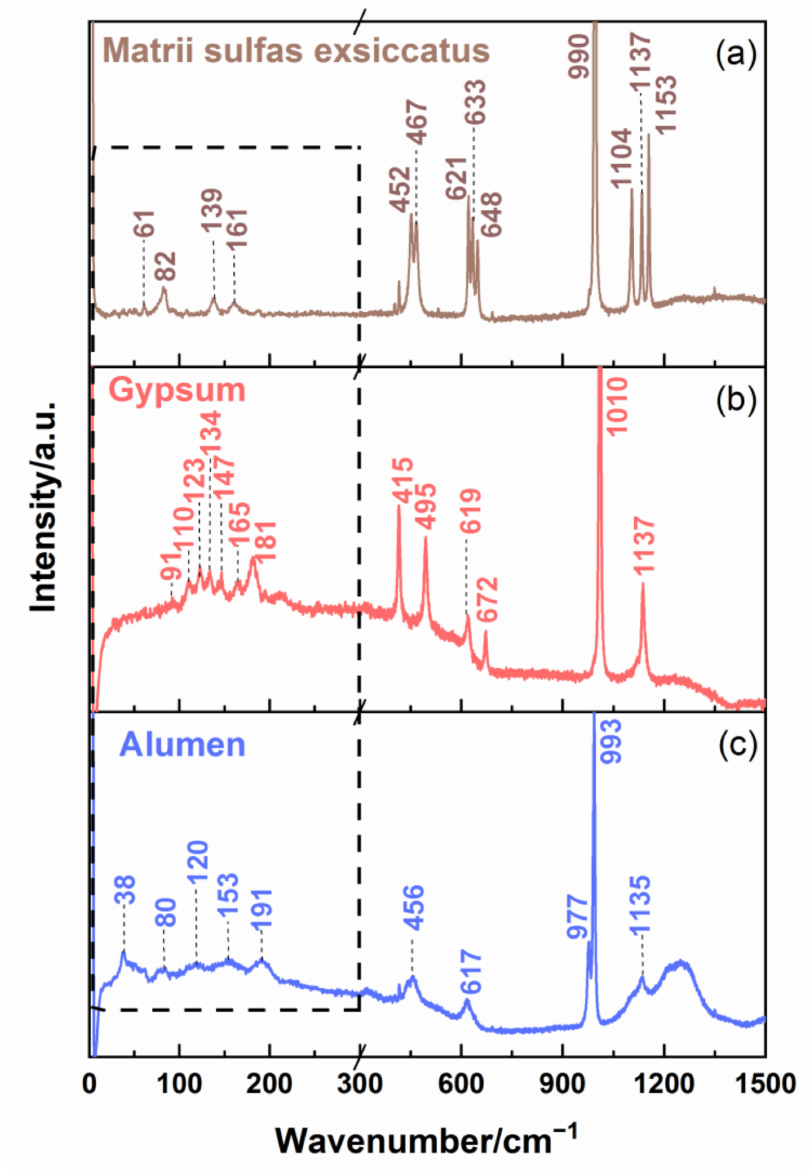
Figure 4. The Raman spectra of ( a ) matrii sulfas exsiccatus, ( b ) gypsum, and ( c )